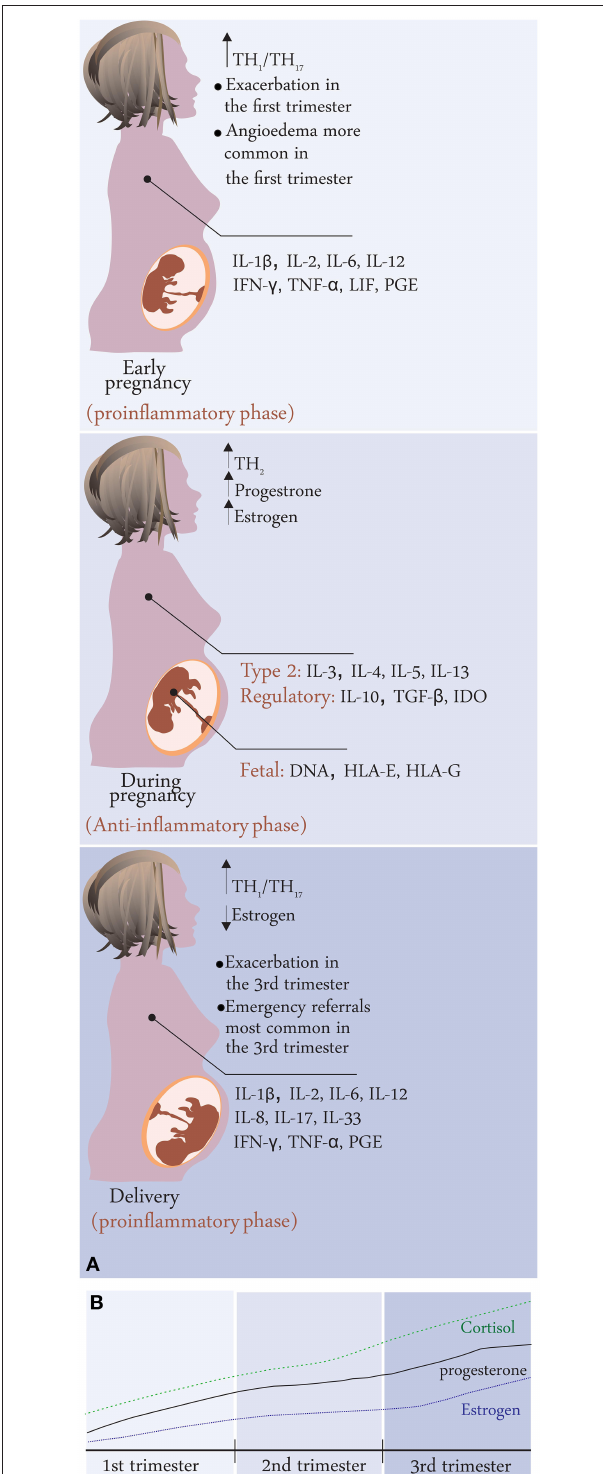
Frontiers in Allergy |